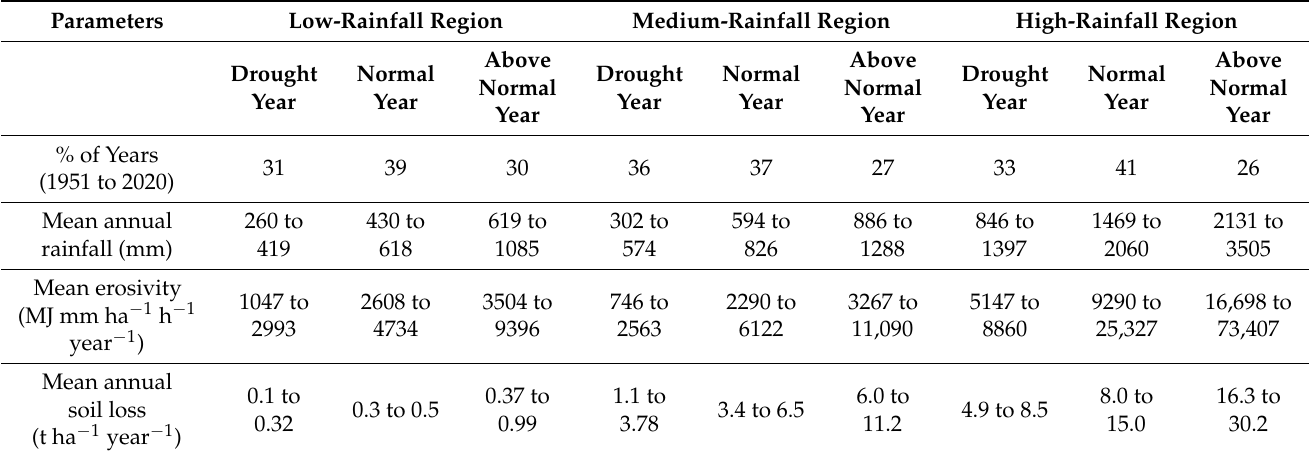
Table 4. Temporal variation in rainfall, erosivity, and soil loss for high, medium and low-rainfall regions of Belgavi district during drought, normal, and above normal years during 1951 to